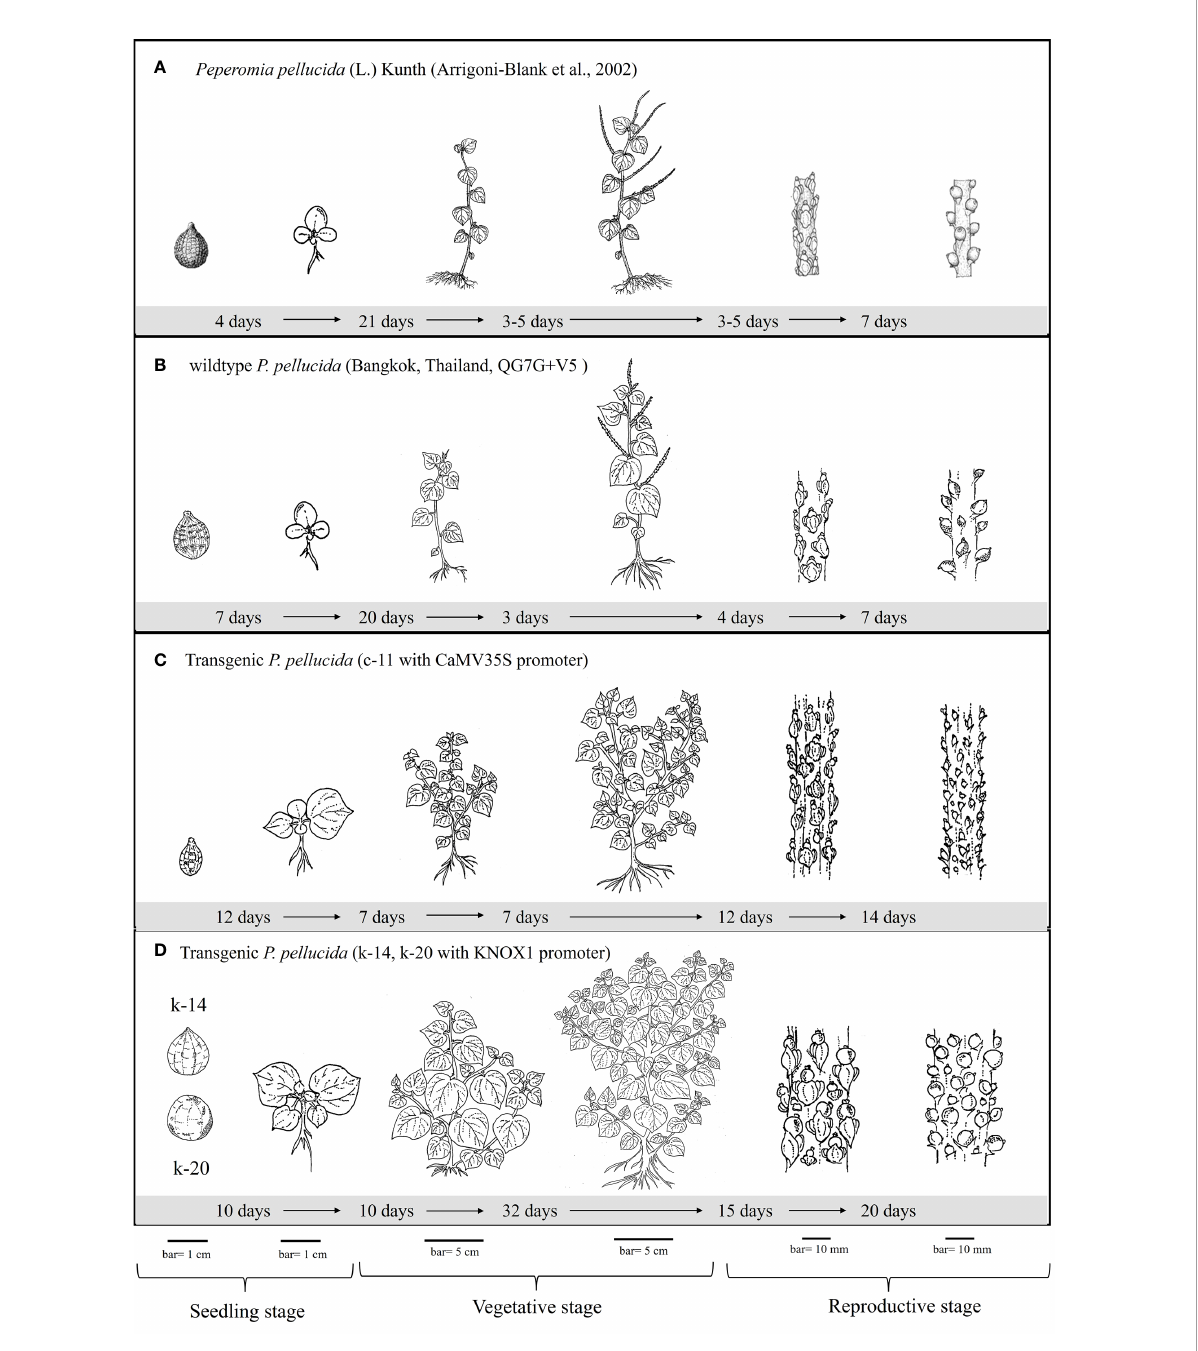
FIGURE 3 Illustration of growth and developmental performances demonstrate the characteristics of seed (bar = 1 cm), seedling (bar = 1 cm), branching shoot with leave (bar = 5 cm), in fl orescence and seed set (bar = 10 mm) of wildtype (B) and transgenic P. pellucida plants; line c-11 obtained from CaMV35S promoter (C) in comparison with those transgenic lines k-14 and k-20 obtained from KNOX1 promoter (D) . The growth and developmental cycle were compared according to the reference of specimens collected from gardens and fi elds (A) reported by Arrigoni-Blank et al. (2002). The location of P. pellucida wildtype presents in (B) is referred to Faculty of Science, Mahidol University